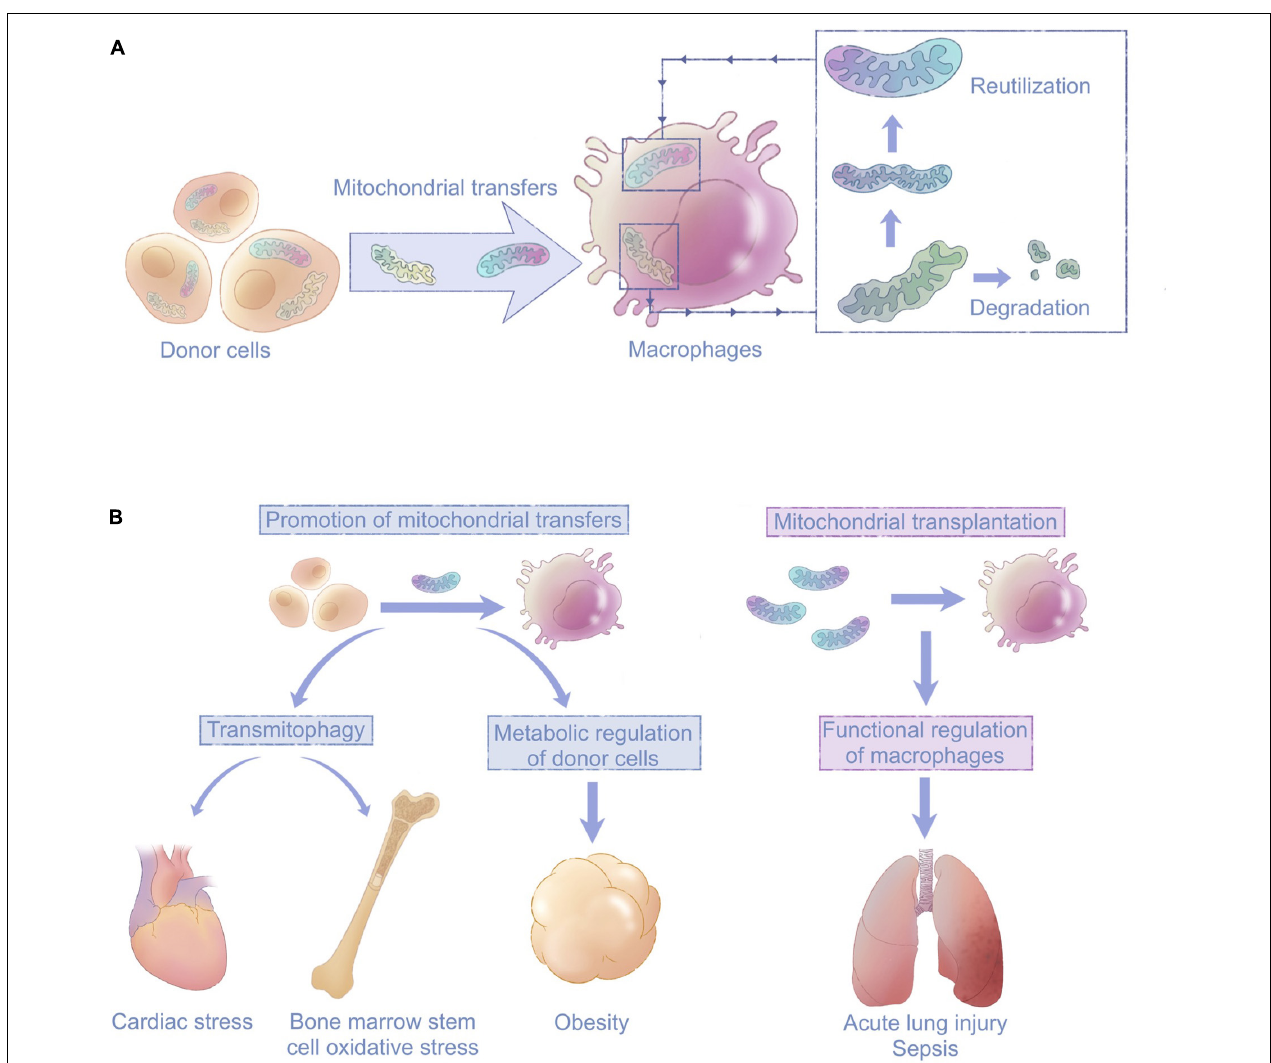
FIGURE 4 | Macrophages are emerging as key players in mitochondrial transfers with clinical implications. (A) Macrophages mediate intercellular mitochondrial transfers of either healthy or damaged mitochondria from surrounding tissue cells. Transferred healthy mitochondria improve the function of recipient macrophages. Damaged mitochondria are degraded via mitophagy to ease donor cells’ stress or reutilized in macrophages. (B) Mitochondrial transfers involving macrophages can be targeted for therapeutic purposes through promotion of mitochondrial transfers or mitochondrial transplantation; this is a promising approach for diseases including cardiac stress, obesity, acute lung injury, and sepsis.